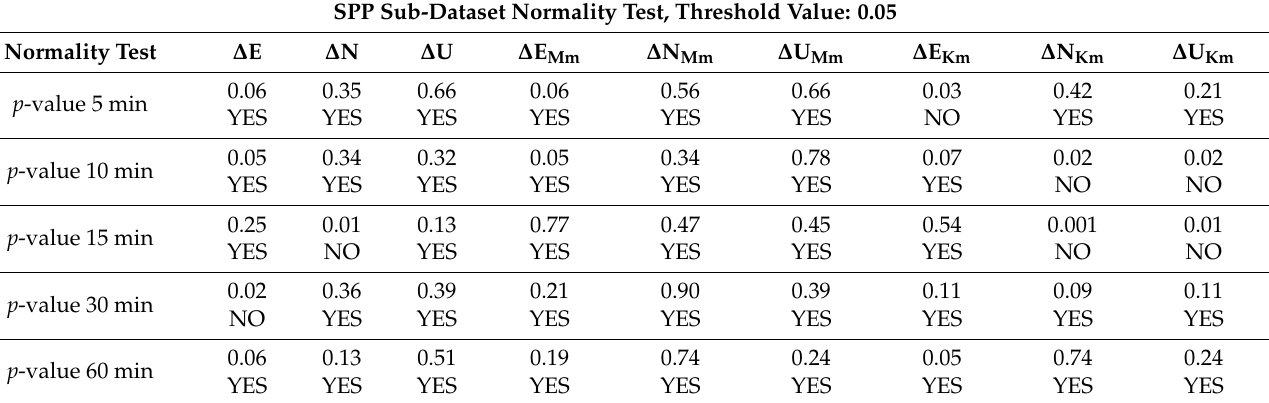
Table 4. Normality test for Single Point Positioning error. SPP Sub-Dataset Normality Test, Threshold Value: